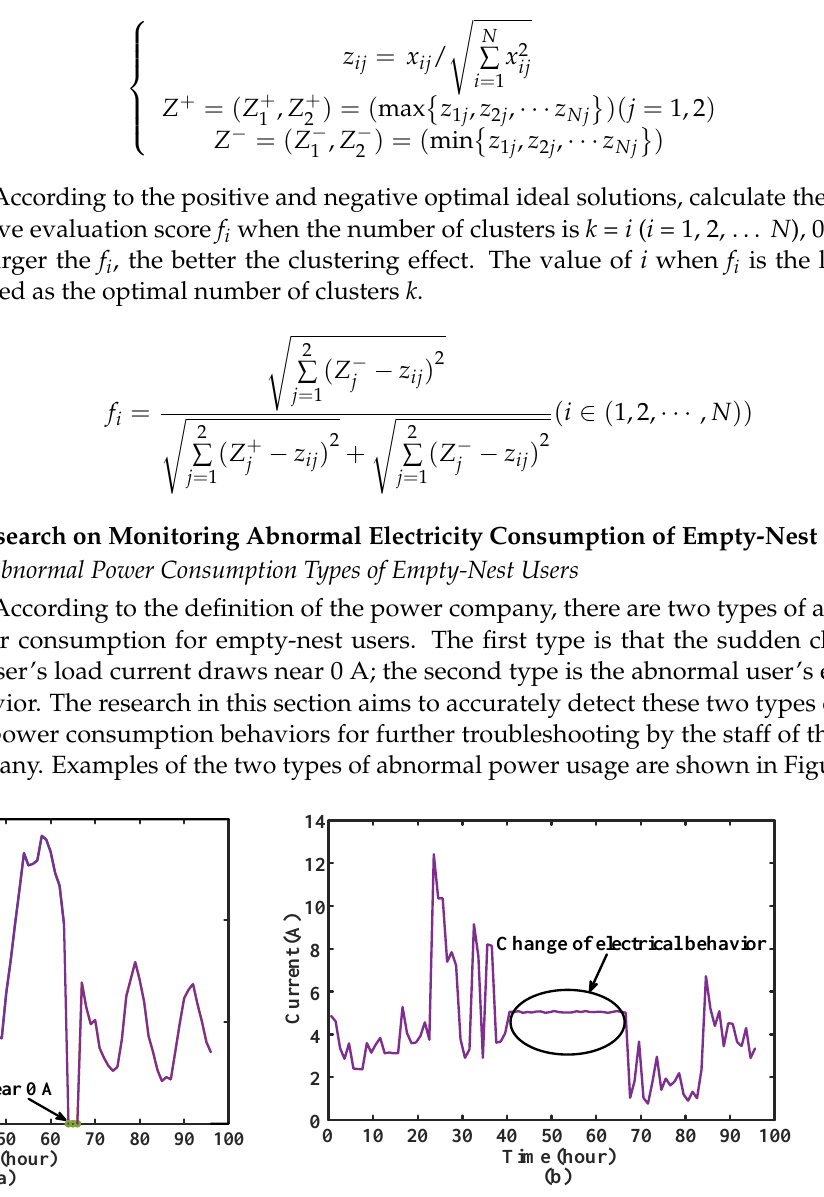
Figure 4. The two abnormal electricity consumption types of empty-nest users, i.e., ( a ) Current mutation near 0 A and ( b ) Change of electrical behavior.